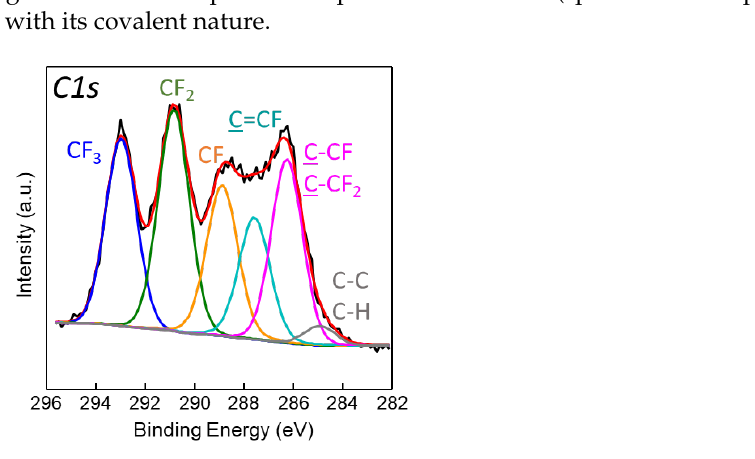
Table 1. XPS surface atomic concentrations of the plasma-polymerized coating deposited on a sili- con substrate.